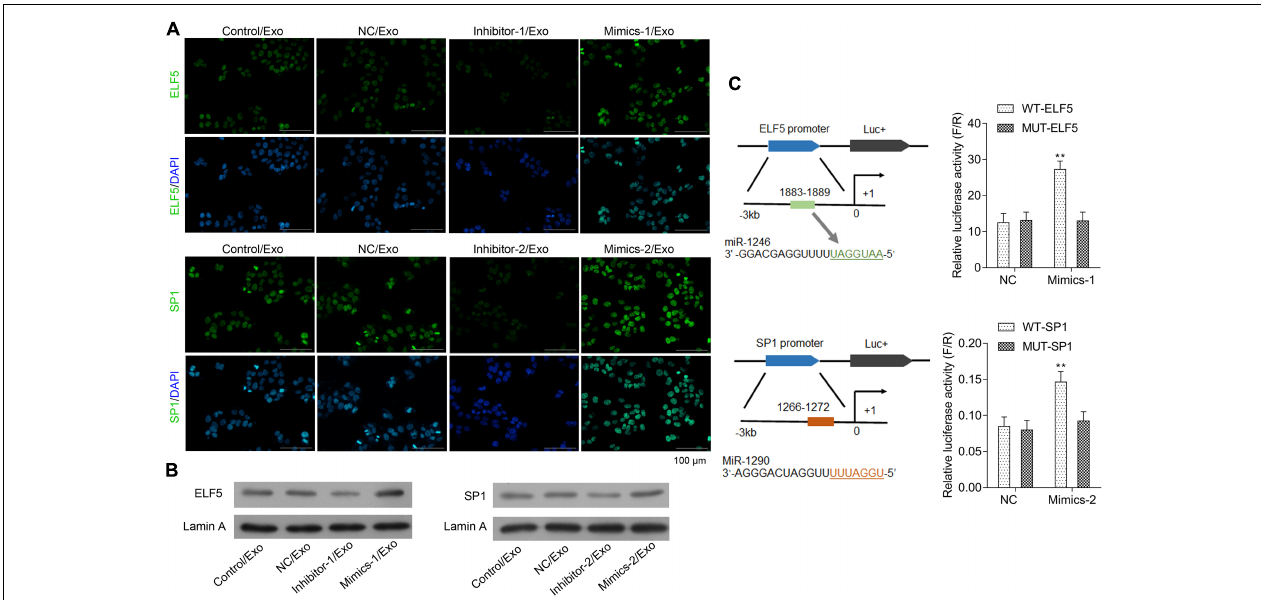
FIGURE 4 | Interaction between miR-1246 and ELF5, miR-1290, and SP1. In HCFs treated with Con/Exo, NC/Exo, inhibitor-1/Exo, Mimics-1/Exo, inhibitor-2/Exo, or Mimics-2/Exo, the expressions of ELF5 and SP1 were determined by immunofluorescence staining (A) and by western blot together with Lamin A (B) . Potential binding of miR-1246 to the promoter of ELF-5 and miR-1290 to that of SP1 and induced expressions of the genes were observed in luciferase report assay (C) . N = 3. ** P < 0.01 vs. NC group. Exo, exosomes; Mimics-1, miR-1246 mimics; Mimics-2, miR-1290 mimics; Inhibitor-1, miR-1246 inhibitor; Inhibitor-2, miR-1290